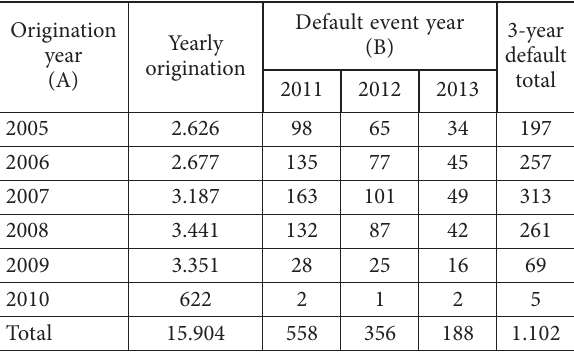
Table 1. Data structure and yearly defaults (source: authors’ compilation from Freddie Mac’s